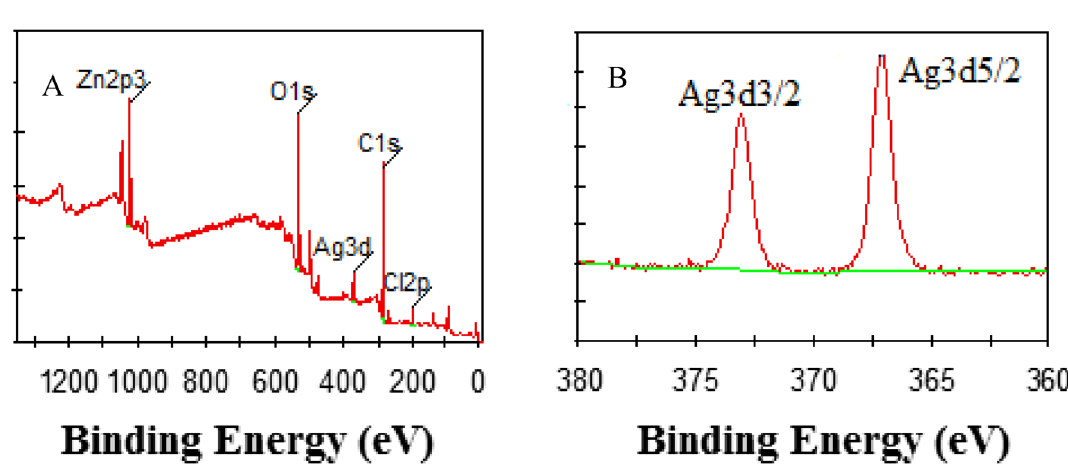
Figure 2. Scanning XPS spectrum ( A ) of the samples synthesized at 60 °C with 65% (w/w) of ZnCl 2 solution, and the corresponding high-resolution XPS spectra ( B ) of Ag